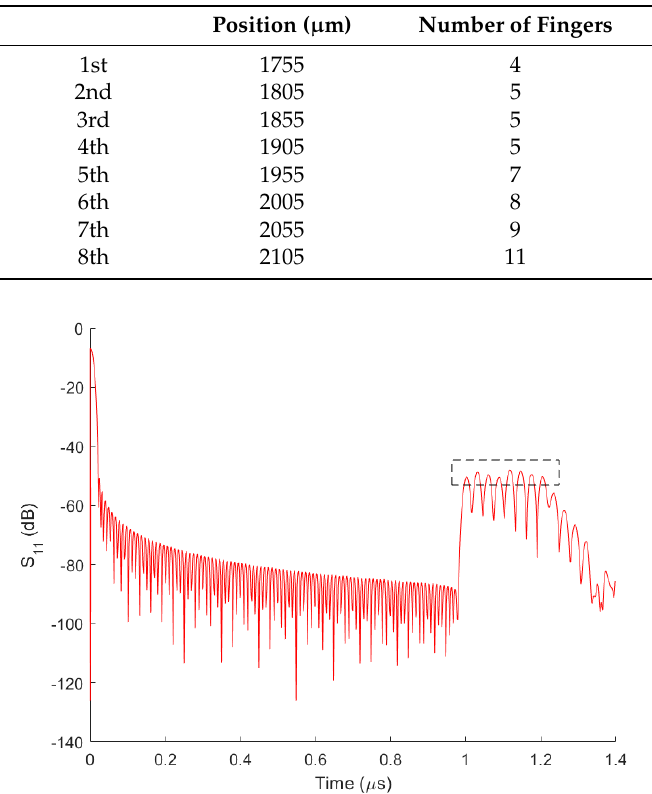
Figure 3. Simulated S11 amplitude response of the SAW sensor with the reflector design parameters in Table 1.